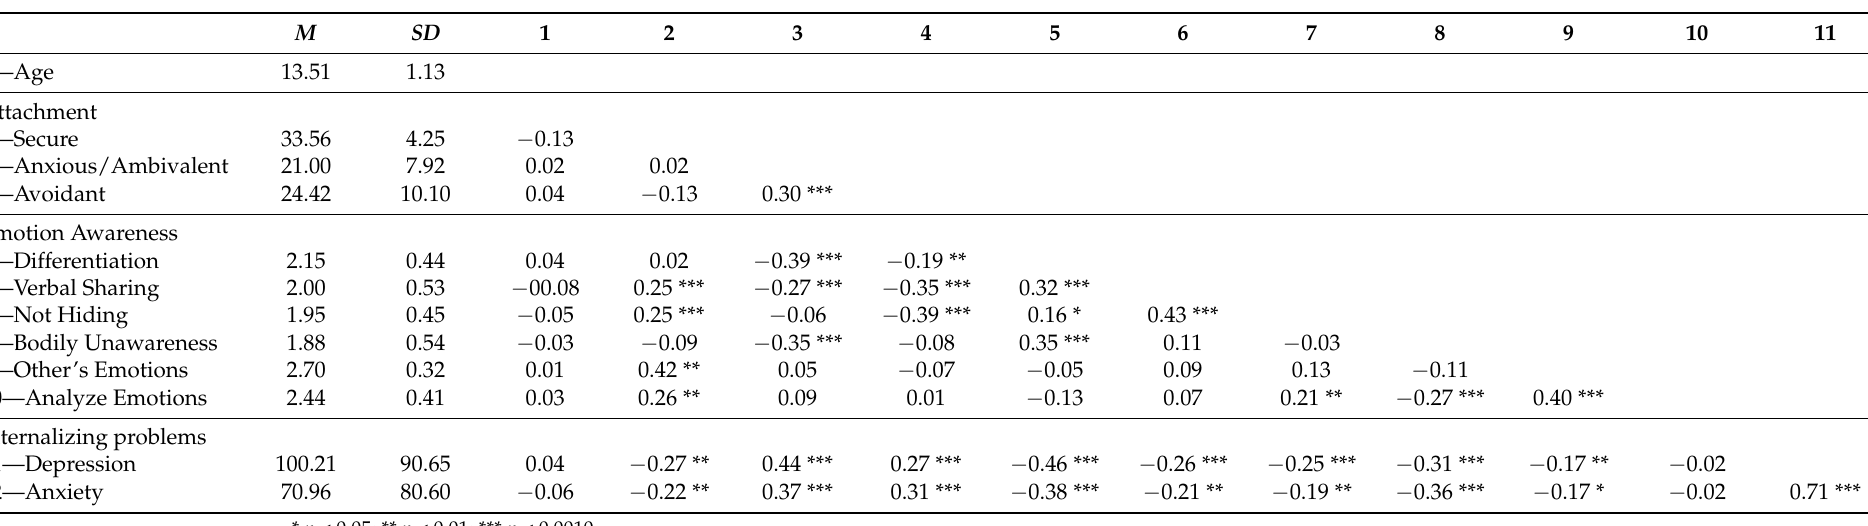
Table 1. Descriptive statistics and Pearson’s correlations between age, attachment patterns, emotion awareness dimensions, and internalizing problems ( n =